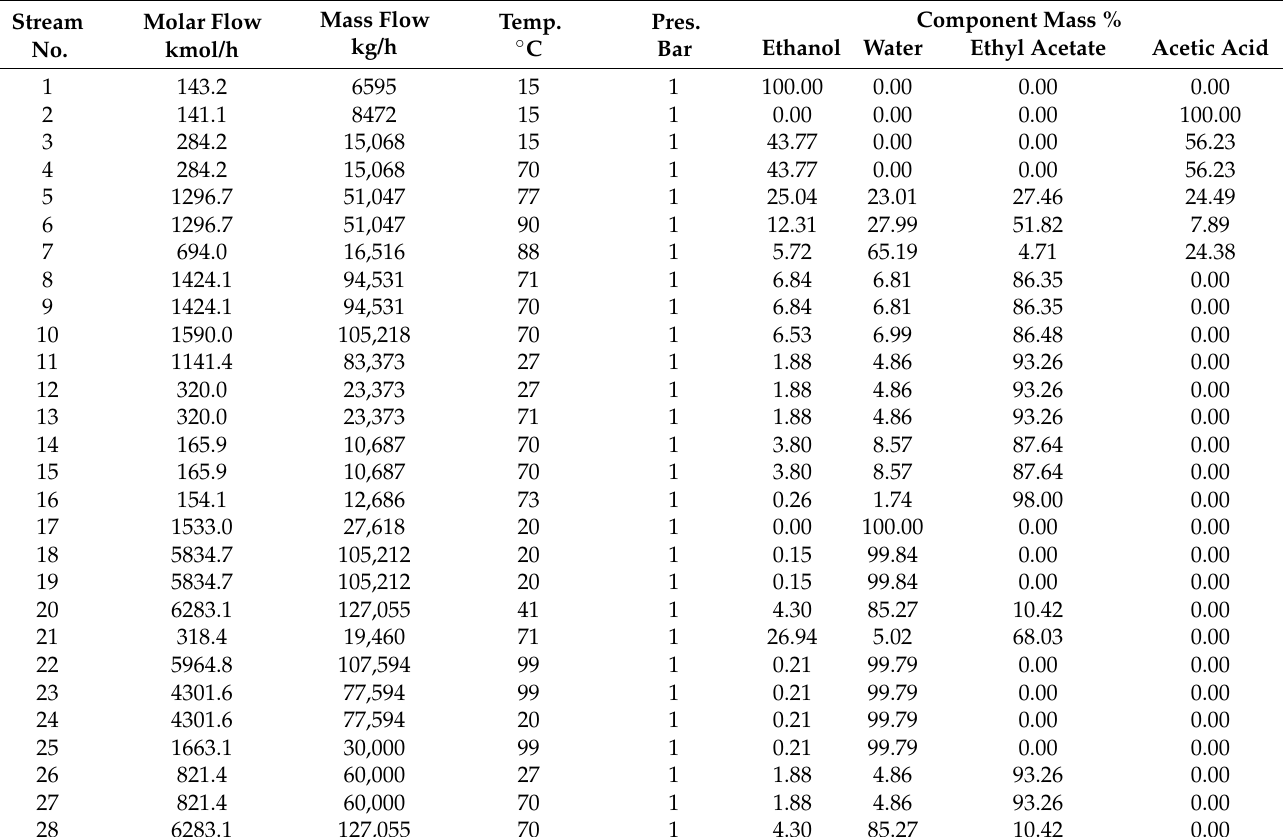
Table A3. Mass balance of the typical installation to produce EA, strategy 3